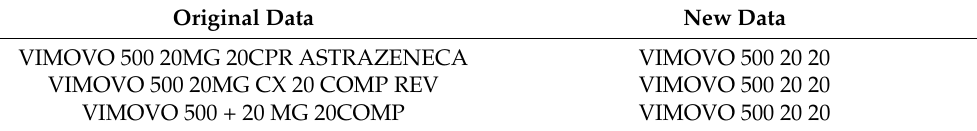
Table 2. Extracting information after using the filter mechanism in one data sample.